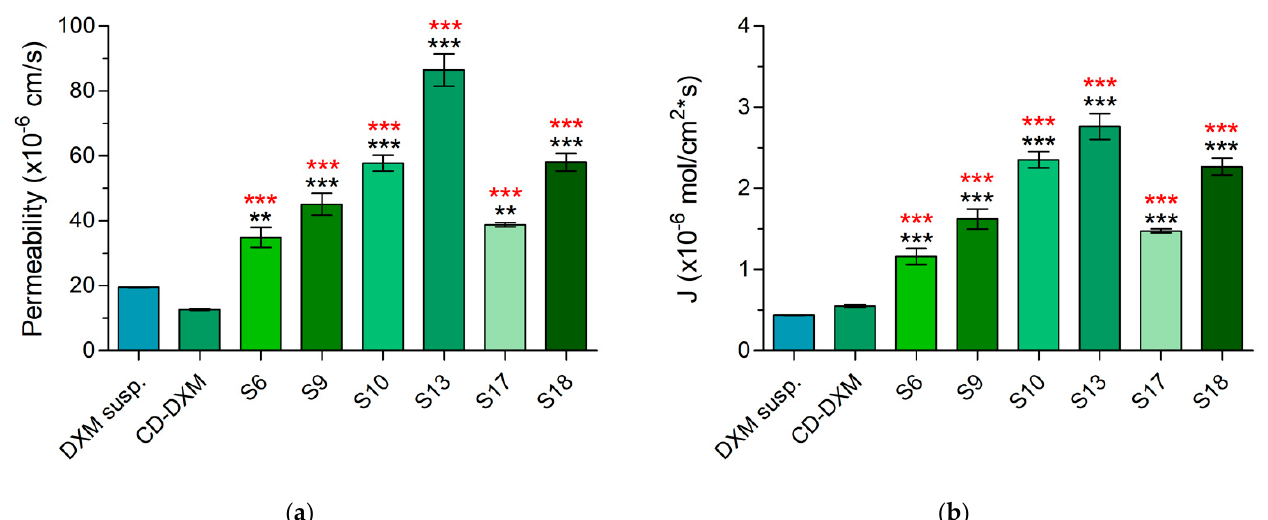
Figure 11. Comparison of corneal-PAMPA parameters of optimal formulations with DXM suspen- sion. Statistical analysis: one-way ANOVA followed by Dunnett’s test. (* p ≤ 0.05 significant; ** p ≤ 0.01 very significant; *** p ≤ 0.001 highly significant difference. The difference from DXM suspension is indicated with black, the difference from CD-DXM solution is indicated with red). ( a ) Permeabil- ity of DXM suspension, CD-DXM solution, and in situ gelling formulations. ( b ) Flux of DXM from DXM suspension, CD-DXM solution, and in situ gelling samples.